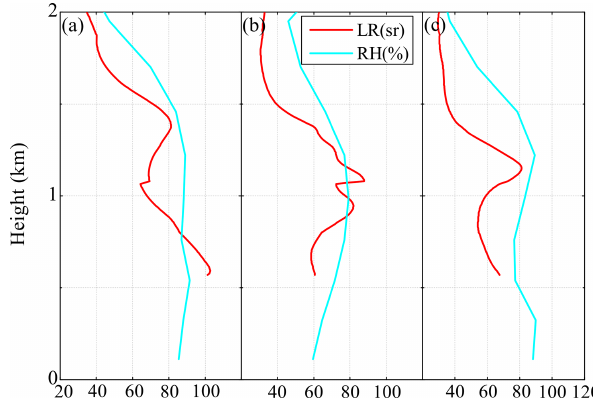
Figure 10. RH and LR profiles in three cases: (a) 8 December 2017, 20:00; (b) 17 March 2018, 16:00; (c) 23 September 2018,